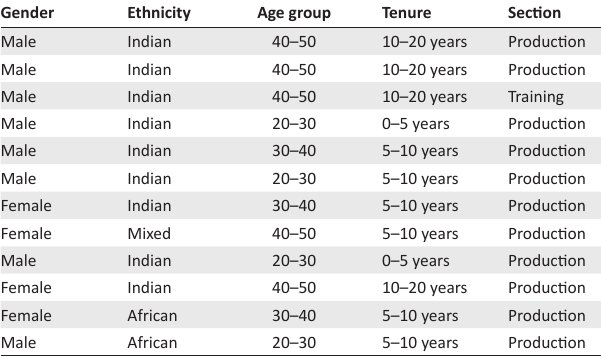
TABLE 1: Profile of research